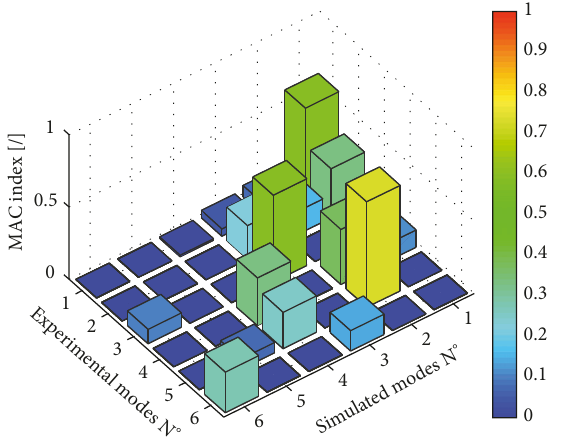
Figure11:MACcoefficientforthedoortest,beforegeometryrefine- ment.